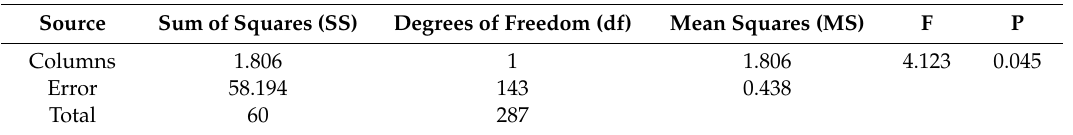
Table 4. Friedman’s analysis of variance (ANOVA) table for the experimental results of Methods 1 and 2.